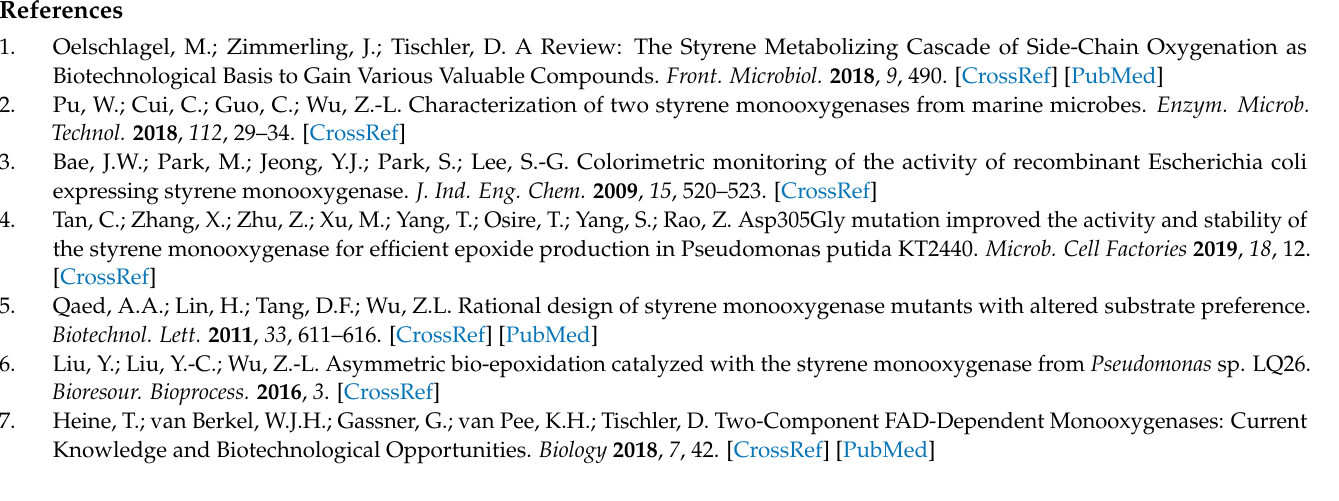
oxide, Figure S11: 1 H-NMR spectrum of ( S )-allylbenzene oxide, Figure S12: 1 H-NMR spectrum of (2 R ,5 R )-1,2:5,6-diepoxyhexane, Figure S13: 1 H-NMR spectrum of ( S )-4-(oxiran-2-yl)butan-1-ol, Figure S14: 1 H-NMR spectrum of 2-(3-bromopropyl)oxirane, Table S1: Summarised results of SMO purification, Table S2. The evaluation of SMO specific activity during